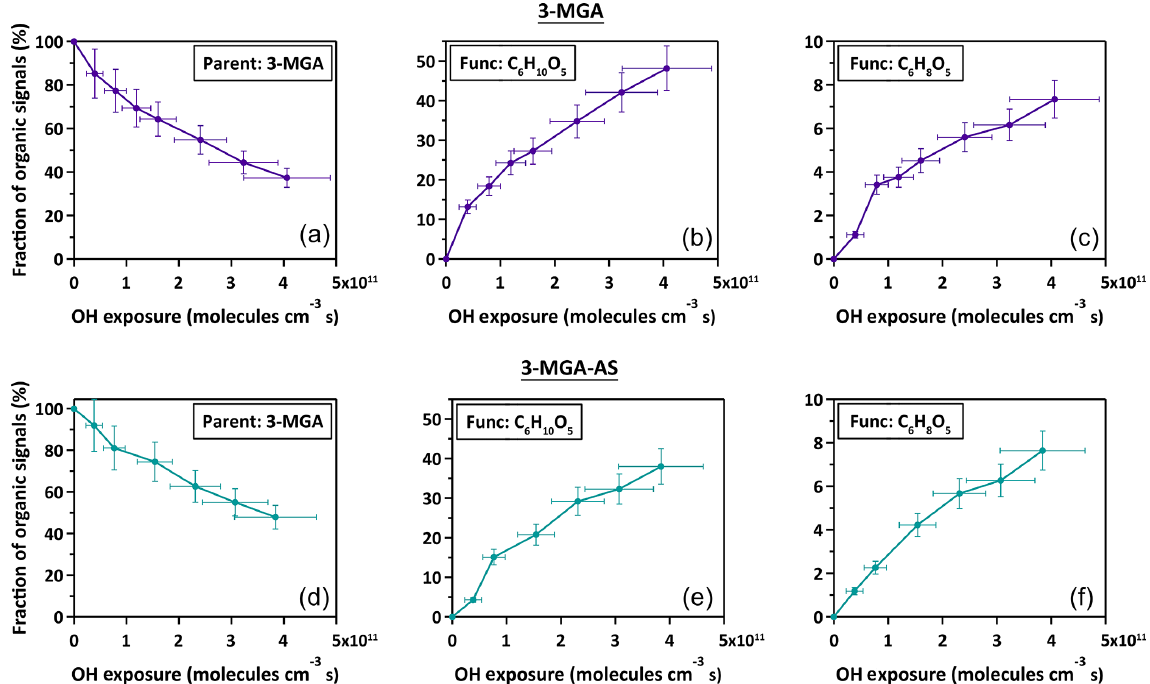
Figure 2. (a, b, c) The fraction of the organic ion signal attributed to the parent 3-MGA, the major C 6 hydroxyl and C 6 ketone products of 3-MGA particles during the heterogeneous OH oxidation shown against OH exposure. (d, e, f) Analogous to the above, but for the case of mixed 3-MGA–AS